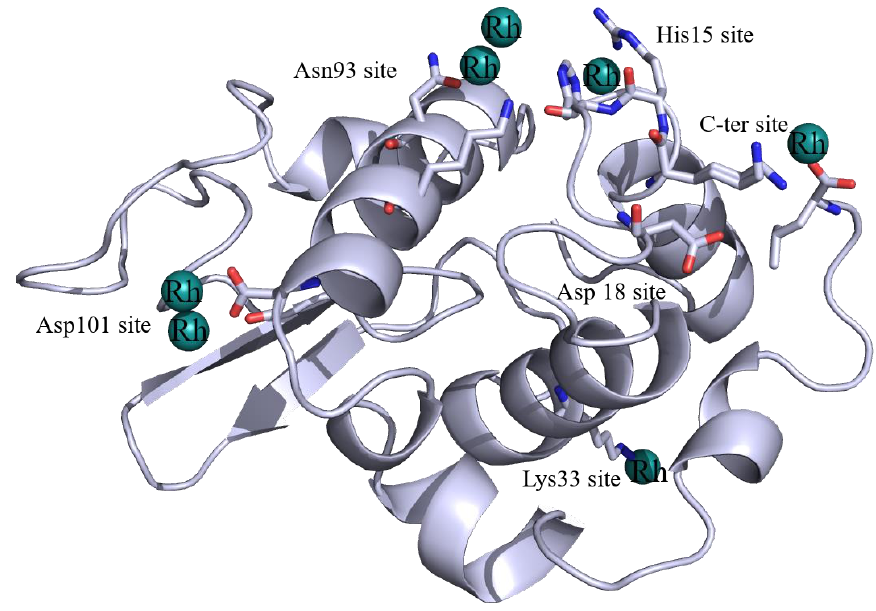
Figure 2. Overall structure of HEWL with identification of Rh binding sites. Int. J. Mol. Sci. 2021 , 22 , x FOR PEER REVIEW